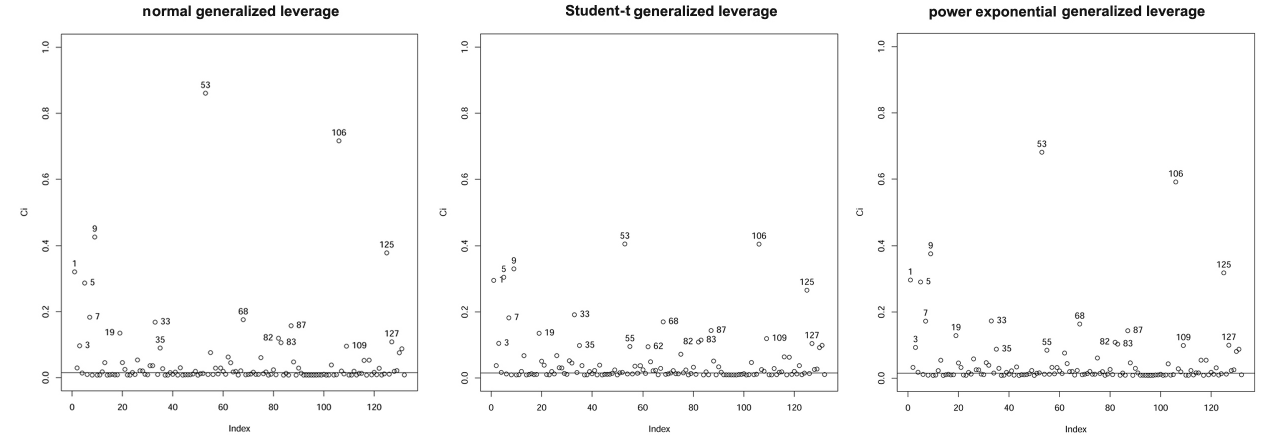
Figure 11. Plots of total local influence C h ( θ ) under case-weight perturbations in the indicated model with data of monthly returns.